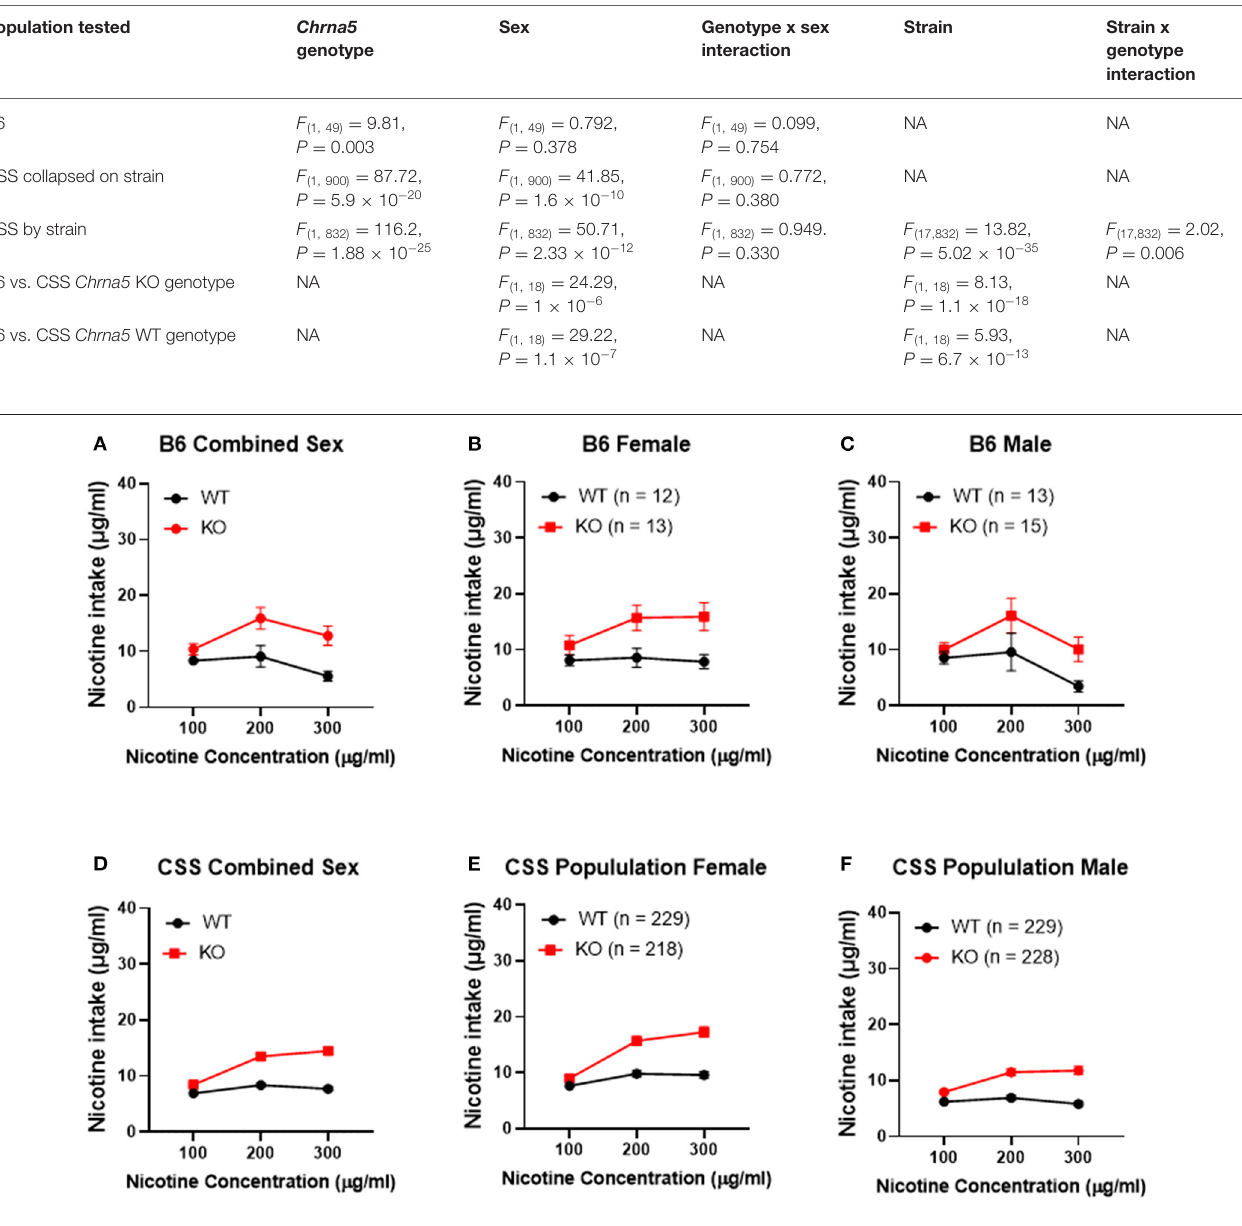
modifiers of the effect of Chrna5 deletion on nicotine intake, the level of nicotine consumption in each CSS homozygous for the Chrna5 null mutation (CSS Chrna5 KO ) was compared to B6 mice homozygous for the null mutation (B6 Chrna5 KO ) in a within genotype analysis ( Table 1 and Figure 3 ). Initial analysis indicated main effects of strain ( P = 1.1 × 10 − 18 ) and sex ( P = 1 × 10 − 6 ). Due to the main effect of sex, the CSS Chrna5